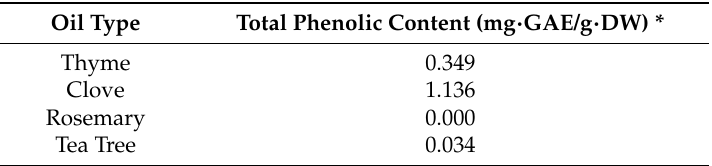
Table 1. Total phenolic content in the investigated essential